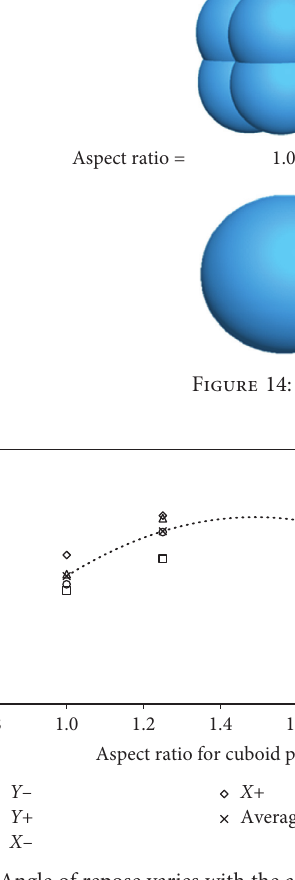
Figure 15: Angle of repose varies with the aspect ratio of cuboids.